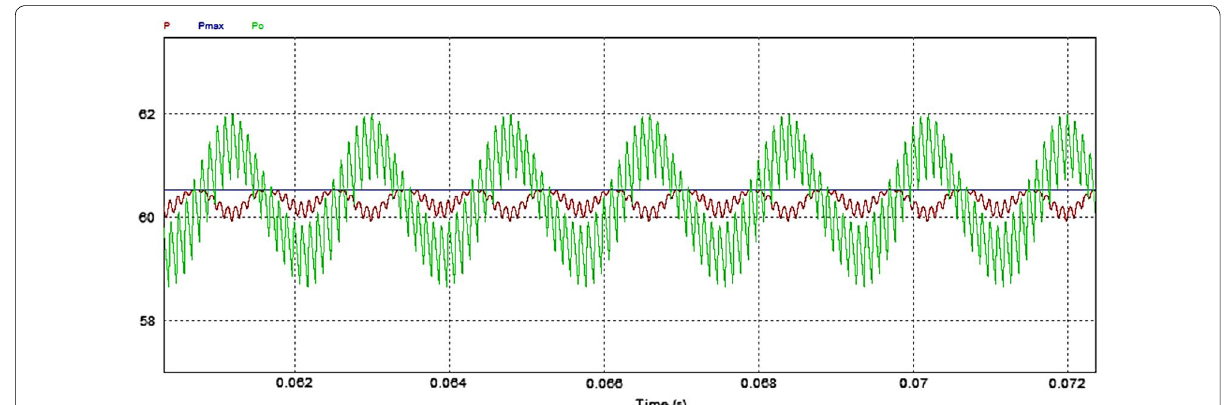
Fig. 9 Zoom in the output powers for INC algorithm under STC